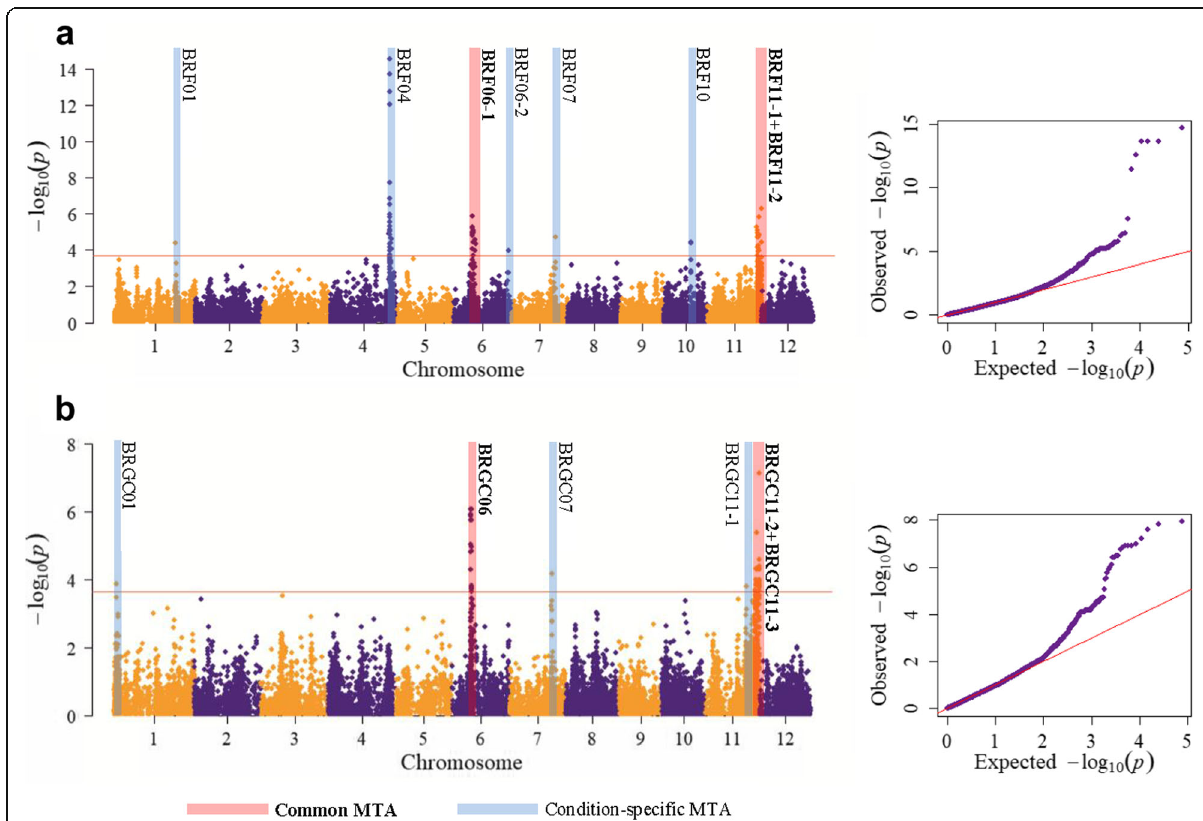
Fig. 2 Results of the association analysis for field ( a ) and growth chamber ( b ) evaluations. Left panel: Manhattan plots of the markers associated with rice blast disease resistance. X axis shows markers along the 12 rice chromosomes and Y axis shows the negative log10- transformed p - values for each association. MTAs detected in both conditions are red-shaded and named in bold; conditions-specific MTAs are blue shaded. Full redlines indicate the 0.05 FDR threshold. Right panel: Q-Q plots of the – log10( p ) of the markers from association